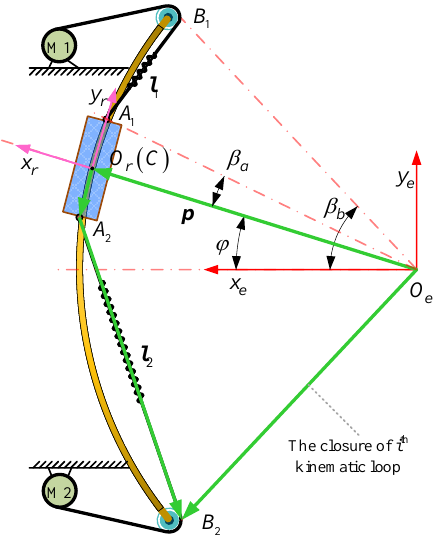
Figure 1. The schematics of the twin-motor cable driven